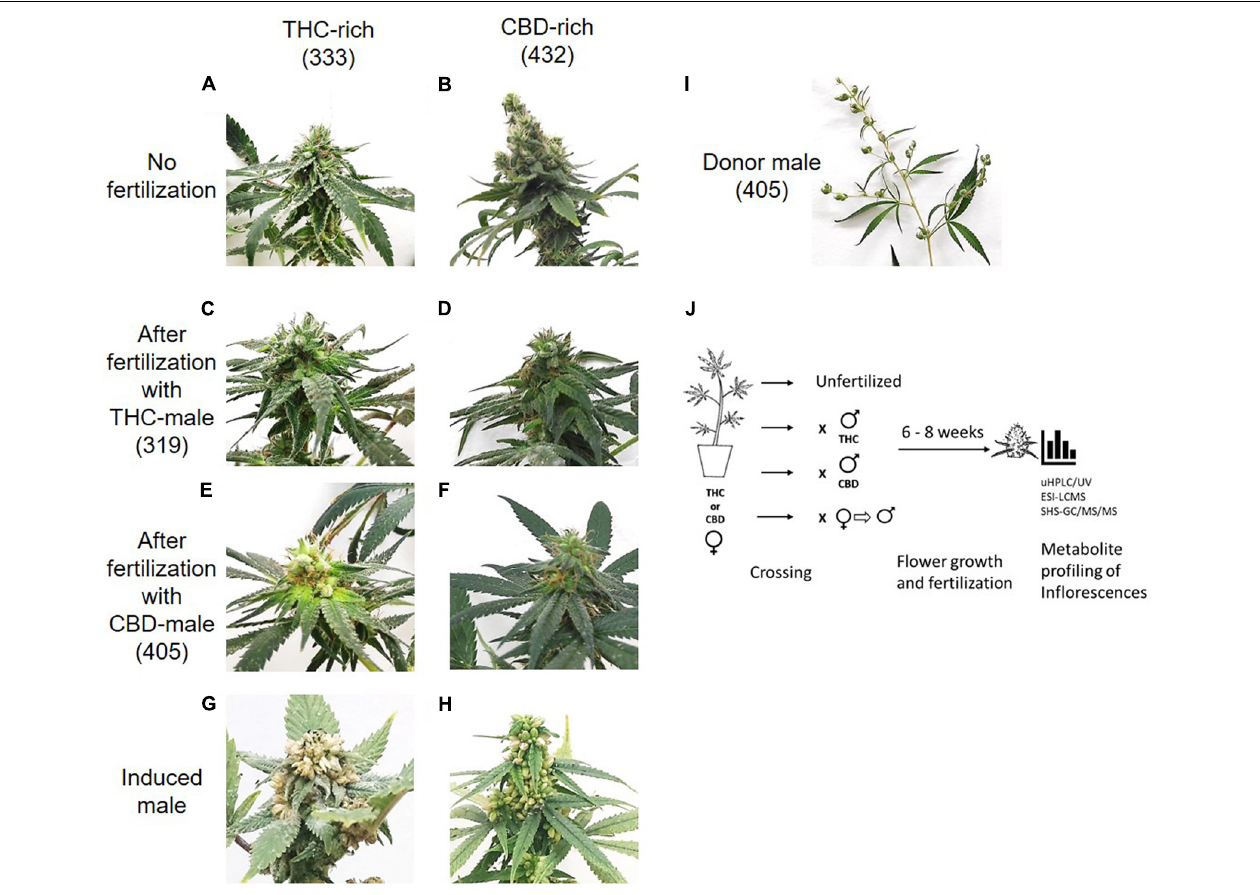
FIGURE 1 | Study design. Differences in inflorescences between THC-rich and CBD-rich plants without (A,B) and after fertilization with either THC-rich male (strain 319) (C,D) or CBD-rich male (strain 405) (E,F) and their respective induced-male plants (G,H) . (I) Representative image of a male donor plant (strain 405). To capture images, the plants were placed on the same white background and photographed individually. (J) Experimental design. Female Cannabis plants of two distinct types, THC- or CBD-rich chemovars, were subjected to fertilization by three different male Cannabis plants: THC- or CBD-rich plants, and an induced-male plant achieved by application of ethylene inhibitor. Female and male plants were incubated together for 6–8 weeks. The profile of their secondary metabolites was analyzed by UHPLC/UV and ESI-LC/MS for phytocannabinoids and SHS-GC/MS/MS for